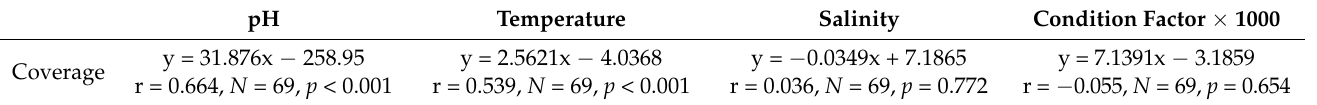
Table 2. Spearman’s rank correlation analysis examines the relationship between pH, temperature, salinity, and the CF of the limpets and the coverage of coralline algae on the limpet shell. Description of symbols: r—Spearman’s Rank Correlation Coefficient; N —number of data; p —the p -value of the correlation. pH Temperature Salinity Condition Factor × 1000 y = 31.876x − 258.95 y = 2.5621x − Coverage r = 0.664, N = 69, p < 0.001